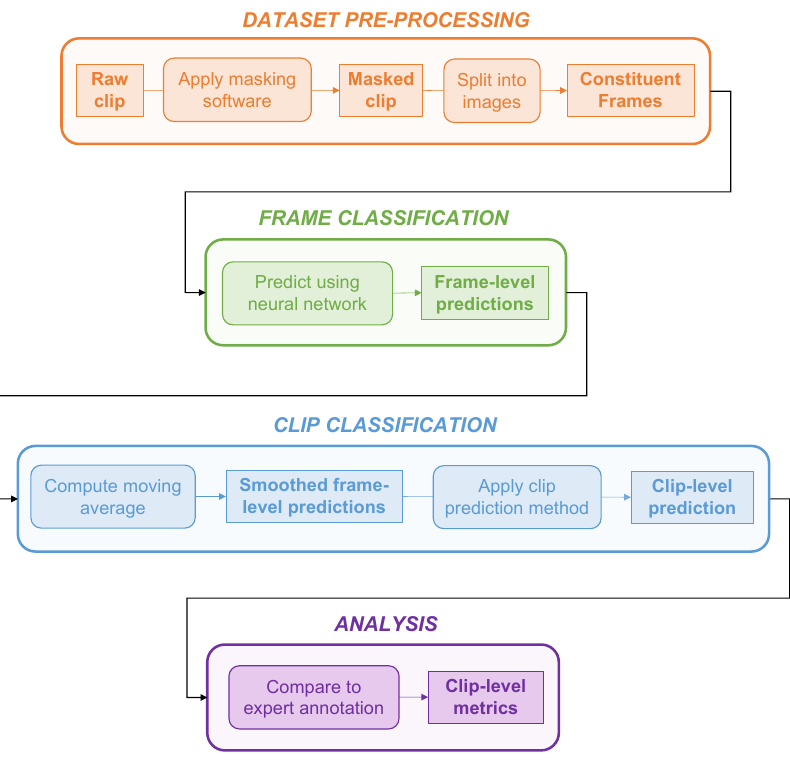
Figure 3. Summary of the view classification workflow. Data pre-processing: raw clips were masked to remove information external to the ultrasound beam, then deconstructed into constituent frames. Frame classification: processed frames were inputted into the neural network, which predicted the probability that the input frame was a pleural view. Clip classification: A moving average was computed over the series of composite frames of a given clip. The smoothed frame-level predictions were then inputted into the contiguous clip prediction method outlined in [28] to generate a whole clip-level prediction. Analysis: Clip-level predictions were compared to expert clinical